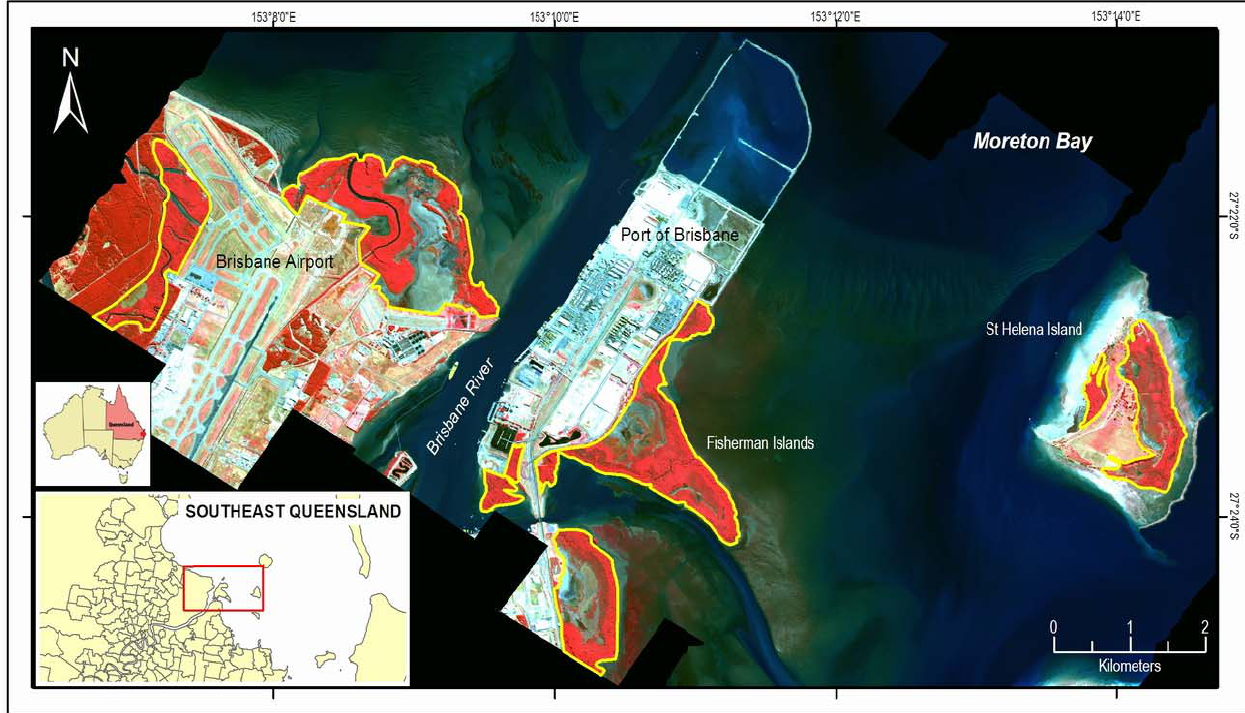
Figure 1. CASI-2 ® image of the study area, the mouth of the Brisbane River, Southeast Queensland, Australia, in false color composite (R: band 29 [799 nm], G: band 15 [650 nm], B: band 9 [540 nm]), acquired on 29 July 2004. The yellow polygons show boundaries of the mapped mangrove.